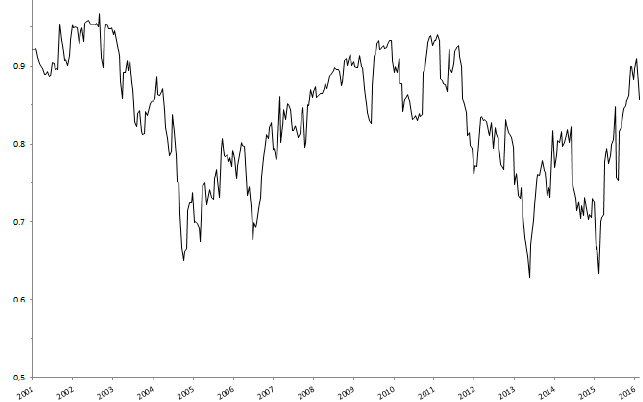
Figure 6. Kendall’s coefficient of concordance pattern.